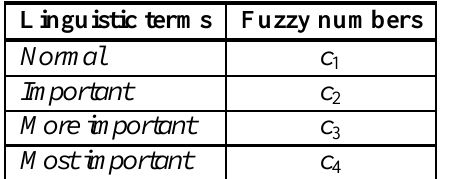
Table 1. Linguistic terms for describing weights of decision